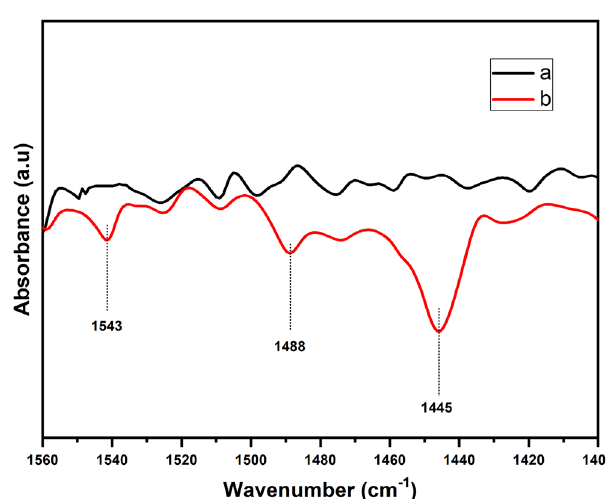
Figure 5. Pyridine-adsorbed FT-IR spectrum of CoMo/γ-Al 2 O 3 -HMS catalyst.